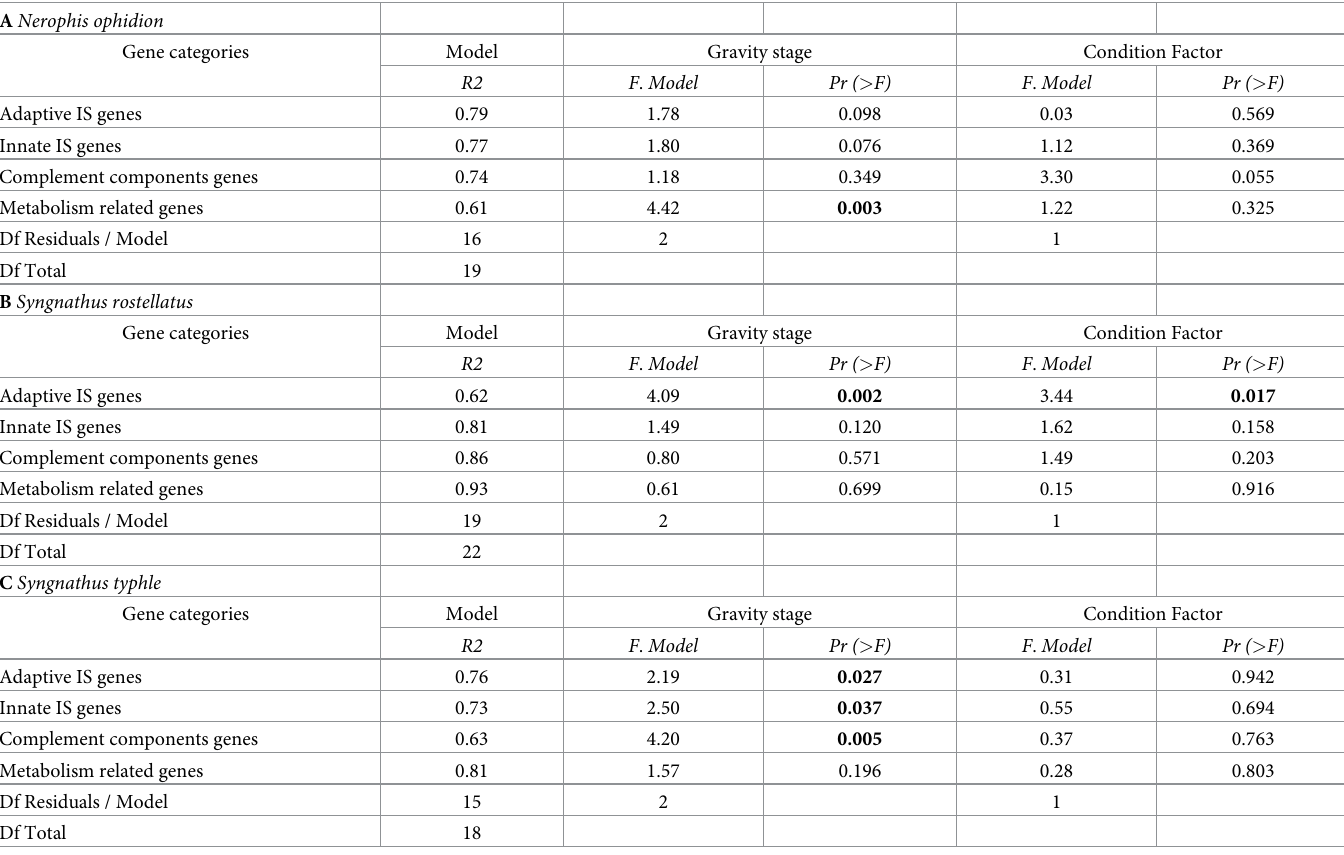
Table 2. Species-specific PERMANCOVA results of candidate gene expression assessing differences in male gravity stages. A condition factor (K = W/TL 3 ) was included as covariable. Significant results are written in bold